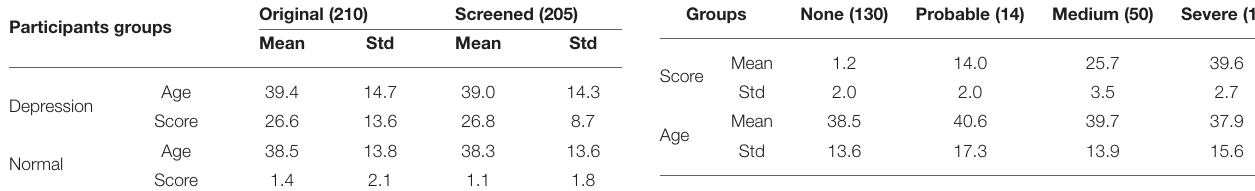
TABLE 1 | Age and HAM-D score in the binary groups. Participants groups